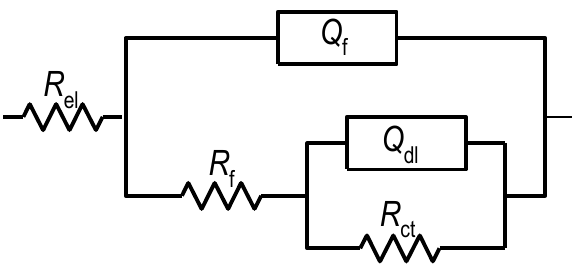
Figure 4. Electrical equivalent circuit (EEC) model used to fit the EIS data.